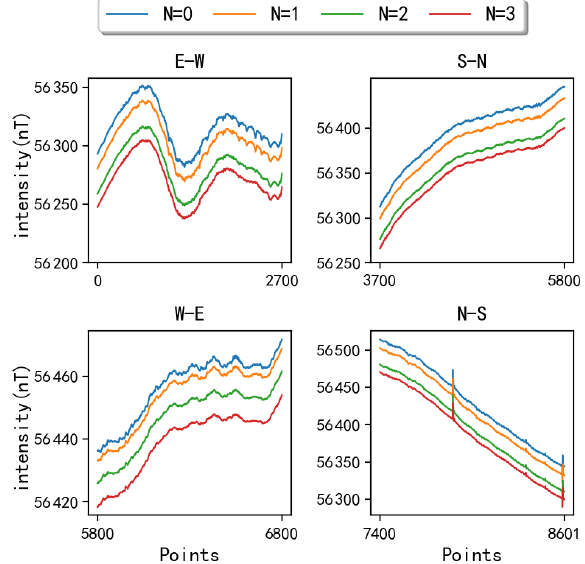
Figure 8. Compensation result of N = 0 , 1 , 2 ,